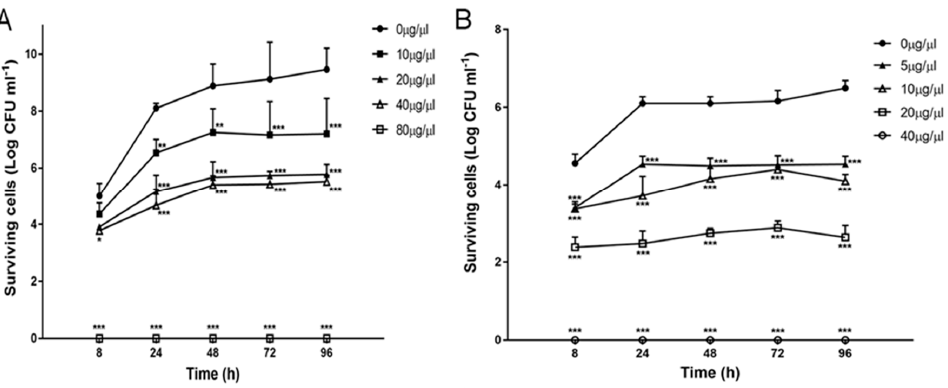
Table 2. Quantitative evaluation of the anti-oomycete and antifungal activity of different Zr-b extracts. n -Hexane Chloroform Oomycete/Fungal Strain